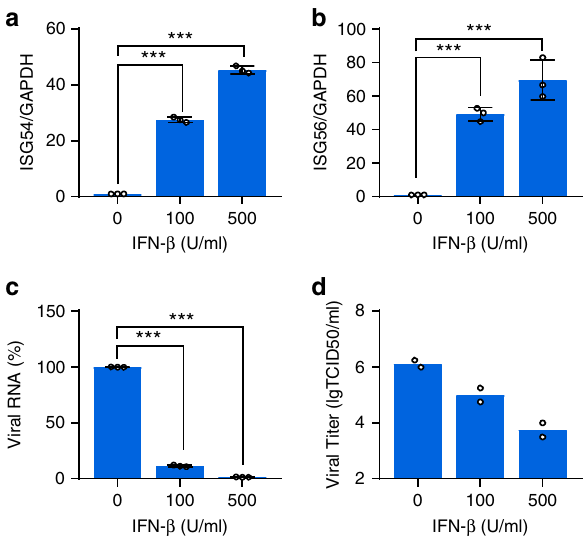
Fig. 8 IFN- β inhibits SARS-CoV-2 replication. a , b Expressions of ISG54 and ISG56 upon IFN- β treatment. Calu-3 cells were left untreated or treated with 100 or 500 U/ml of recombinant human IFN- β for 18 h. Total RNA was extracted, and the ISG54 and ISG56 mRNA were detected by qRT-PCR. c Susceptibility of SARS-CoV-2 to IFN- β treatment. Calu-3 cells were left untreated or pretreated with 100 or 500 U/ml human IFN- β for 18 h, and then cells were mock-infected or infected with SARS-CoV-2 at an MOI of 0.5. After 24 h post-infection, SARS-CoV-2 RNA was detected by qRT-PCR using SYBR green. d Viral titer assessment. Supernatants from c were harvested and subjected to TCID 50 analyses for measuring viral titers. All experiments were done at least twice, and one representative is